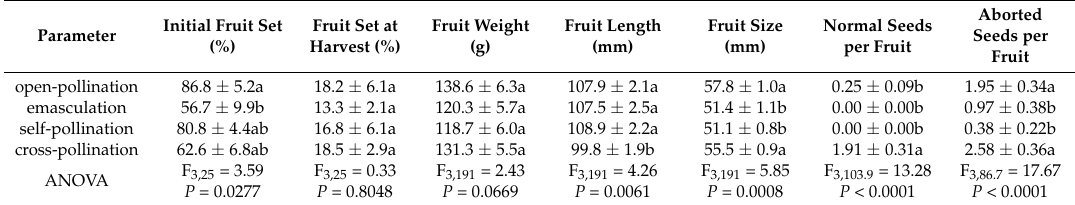
Table 2. Effects of fertilization and intrinsic parthenocarpy on fruit set and fruit parameters in ‘Conference’